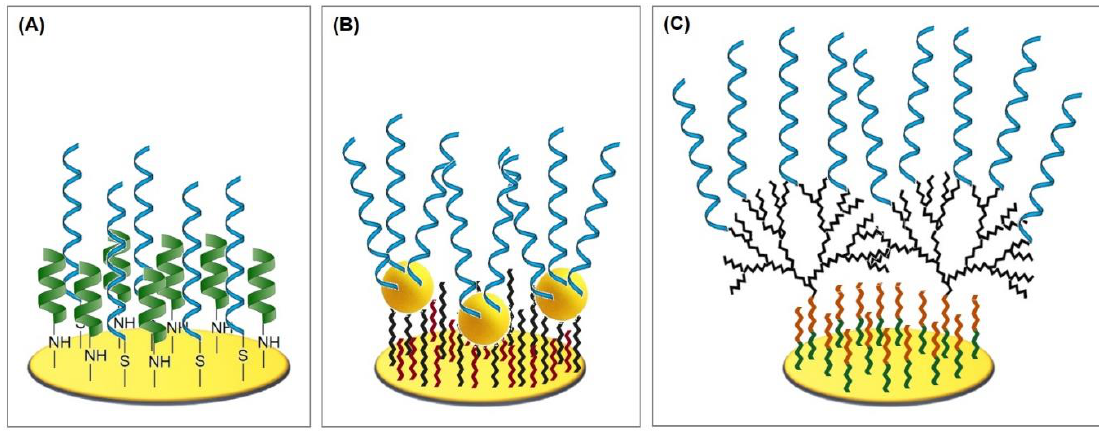
Figure 7. ( A ) Mixed self-assembled monolayer with zwitterionic peptides to inhibit biofouling [77]. ( B ) Gold nanoparticles atop alkanethiol (11-amino-1-undecanethiol) SAM [78]. ( C ) PAMAM dendrimer on cysteamine and glutaraldehyde [42].